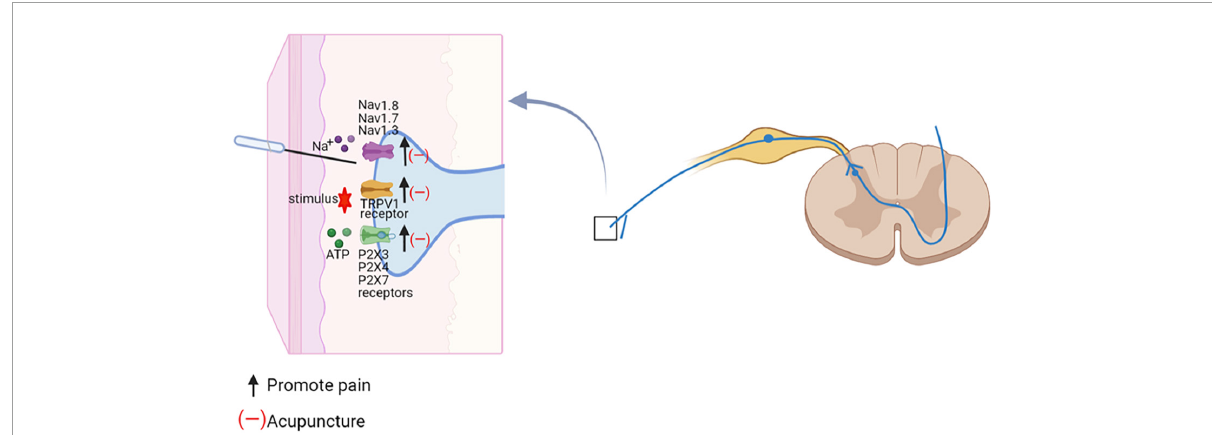
FIGURE5 Acupuncture regulates ion-channel dysregulation in neuropathic pain. The effect of acupuncture on the spinal cord. Na+, sodium ion; Navs, Voltage-gated sodium channels; TRPV1, TRP vanolloid 1; ATP, adenosine triphosphate; P2X3, ATP-gated purinergic channels